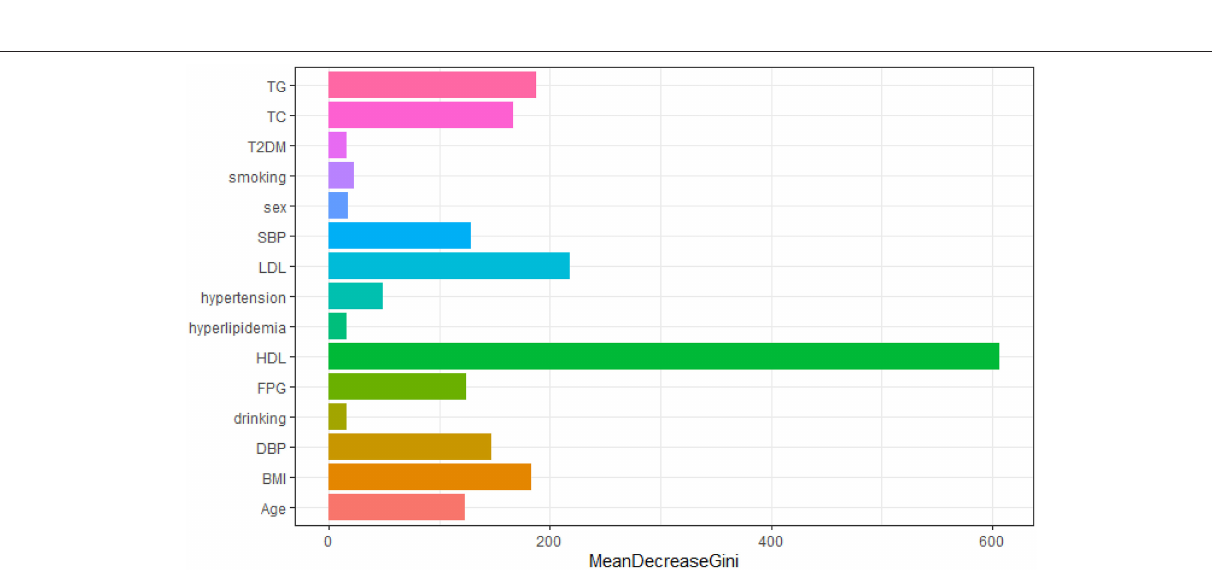
Frontiers in Cardiovascular Medicine |